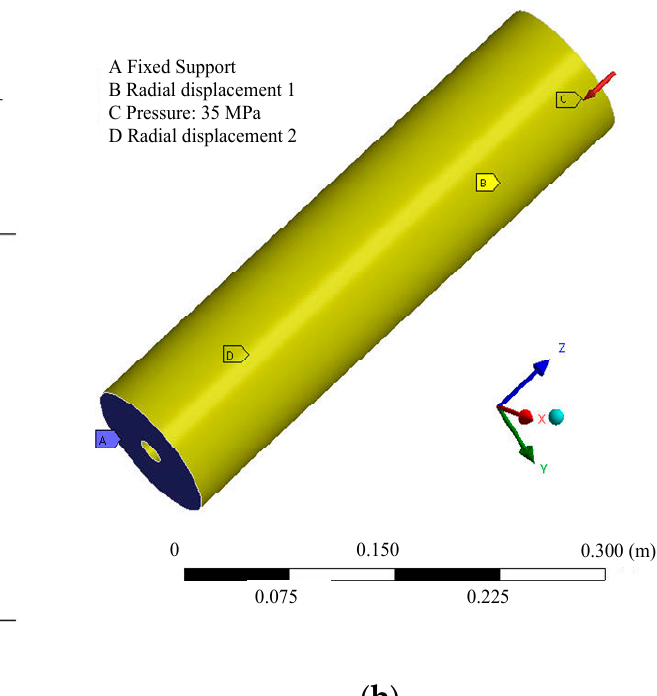
Figure 8. Finite element micromechanical models of fillers with spherical ( a ) and short cylindrical ( b ) inclusions.